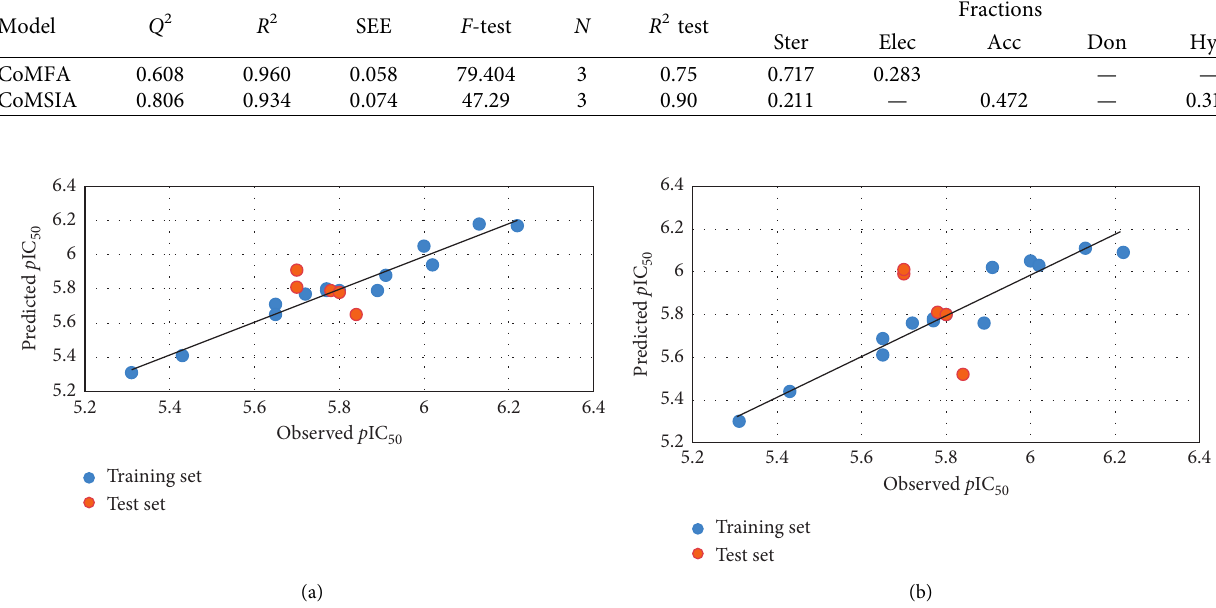
Figure 5: Scatter plot of the predicted values versus the actual p IC50 values based on CoMFA and CoMSIA models. (a) CoMFA/ES model. (b) CoMSIA/SHA model.